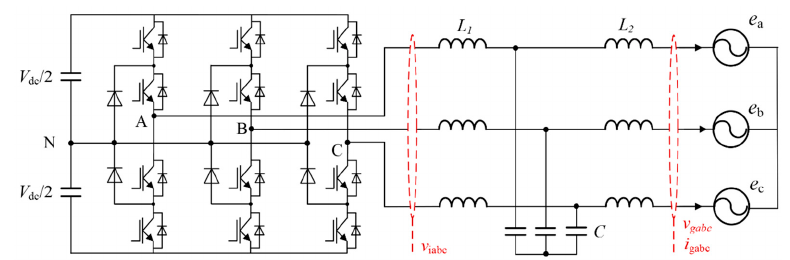
Figure 1. Topology of 3-level neutral point clamped (NPC) converter.